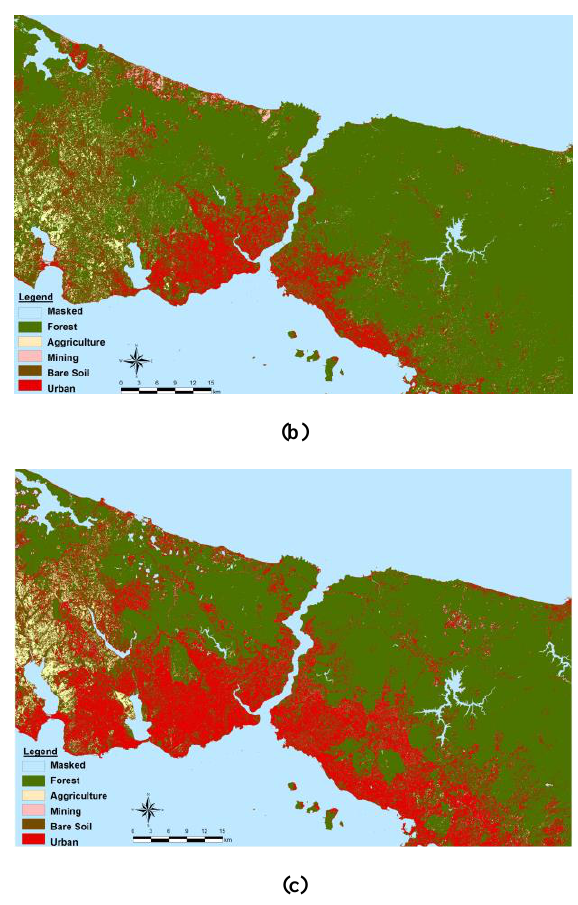
Figure 2: LULC classification maps. (a) 1972. (b) 1986. (c) 2013.